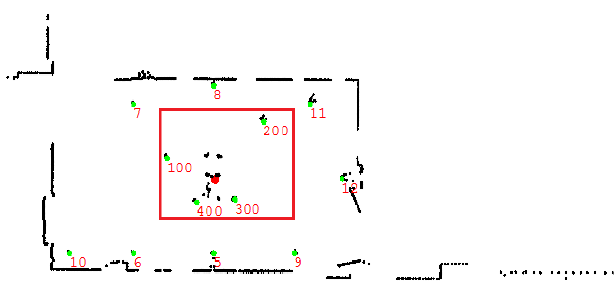
Figure 3. Real-time navigation map.